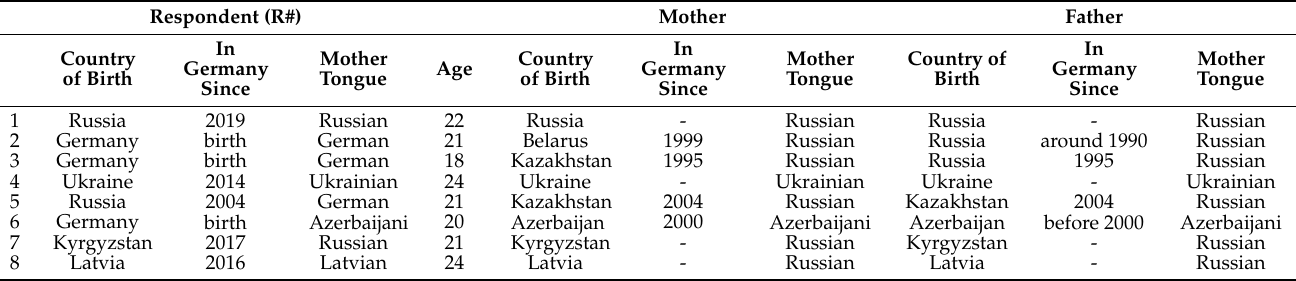
Table 1. Sociodemographic Data of the Respondents.